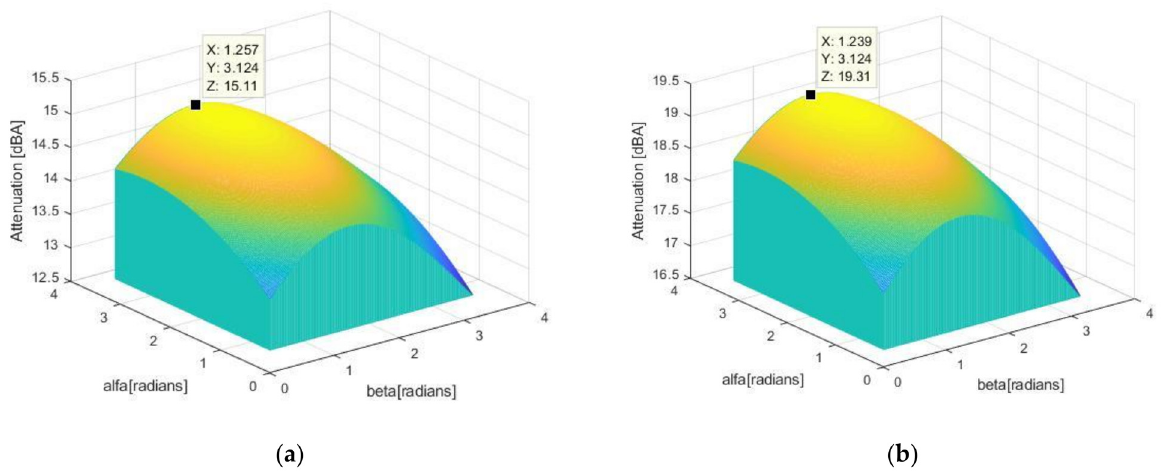
Figure 10. Sound attenuation: Distance barrier-receiver 35 m; relative air humidity 20%; σ e = 104 kPa · s · m − 2 . ( a ) Frequency = 1000 Hz, ( b ) frequency = 4000 Hz.